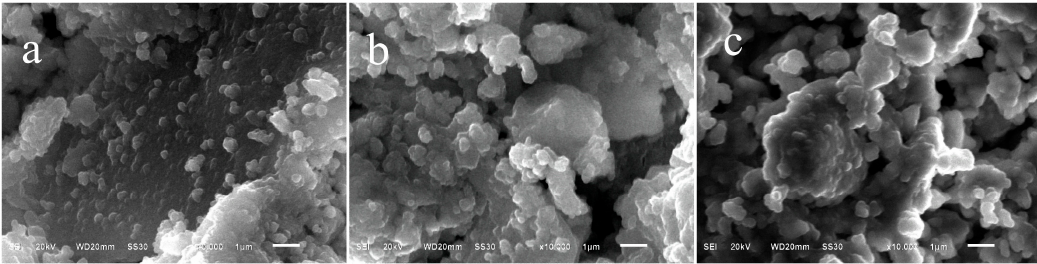
Figure 12. ( a ) The electron density difference in the isosurface (0.1) of the Fe 2 O 3 /Al 2 O 3 slab and ( b ) the total density of state (DOS) for the O atom on the bottom layer of Fe 2 O 3 , as well as that for the O and Al atom on the top layer of Al 2 O 3